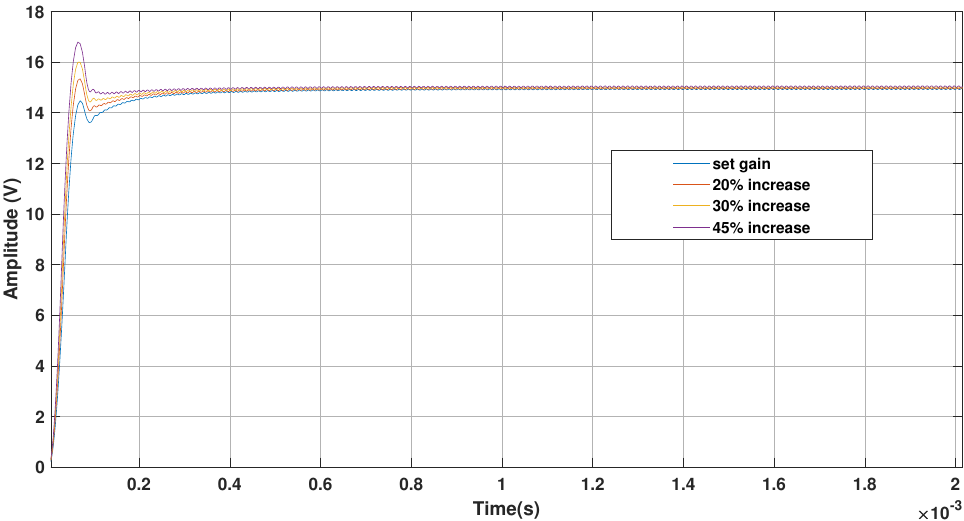
Figure 8. Response of CI optimized FOPID to variation of